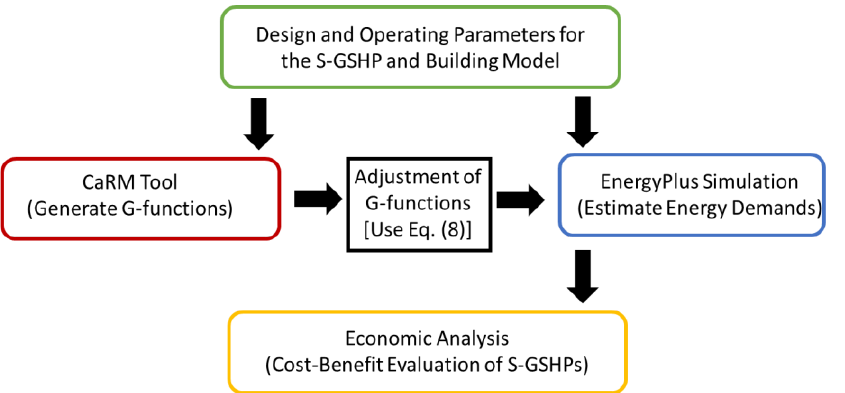
Figure 1. Analysis approach considered to assess the cost-effectiveness of S-GSHP systems.